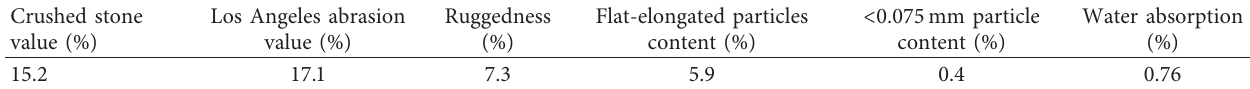
Table 1: Technical indexes of coarse aggregates.